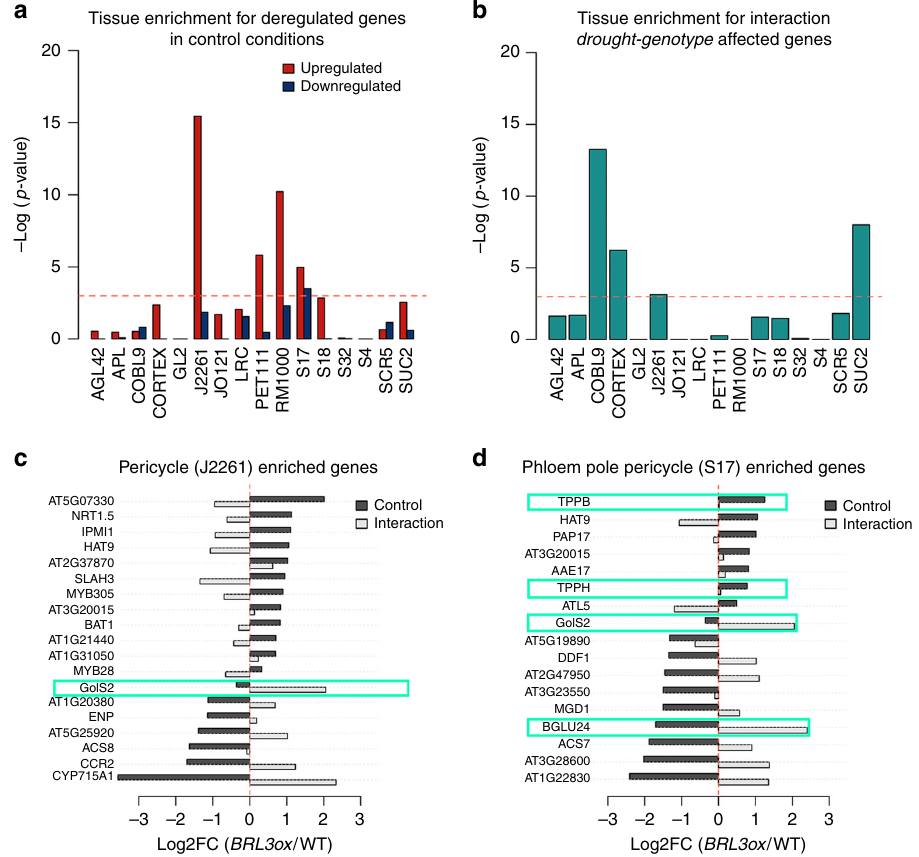
Fig. 6 Enrichment of deregulated genes in BRL3ox root vasculature. a Tissue enrichment for upregulated (red) or downregulated (blue) genes in control conditions. Bars trespassing the p -value threshold (0.05) were considered enriched in the dataset. b Tissue enrichment for genes affected by the interaction genotype*drought. Bars trespassing the threshold p -value < 0.05 were considered enriched in the dataset. a , b Deregulated genes tissue enrichment. AGL42: quiescent center, APL: phloem + companion cells, COBL9: root hair cells, CORTEX: cortex, GL2: non-hair cells, J2661: pericycle, JO121: xylem pole pericycle, LRC: lateral root cap, PET111: columella, RM1000: lateral root primordia, S17: phloem pole pericycle, S18: maturing Xylem, S32: c Deregulated genes enriched in the Pericycle (J2261 marker). d Deregulated genes enriched in the Phloem Pole Pericycle (S17 marker). c , d Bars represent the log 2 -fold-change of BRL3ox vs. WT roots in control (black) or the difference of drought responses between BRL3ox and WT (FC drought/CTRL in BRL3ox — FC drought/CTRL in WT) in the lineal model (gray). Blue boxes highlight enzymes directly involved in the metabolism of deregulated